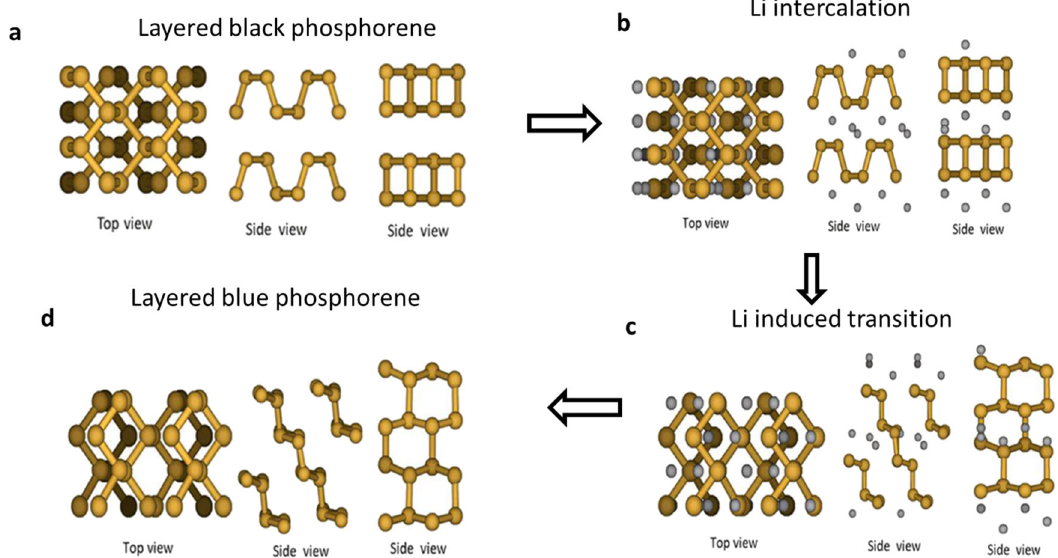
Fig. 10 Structural phase transition from black to blue phosphorene using Li intercalation. a Top and side view of layered black phosphorene, initial b and fi nal c structure of Li intercalated black phosphorene, d fi nal structure of black phosphorene after removing